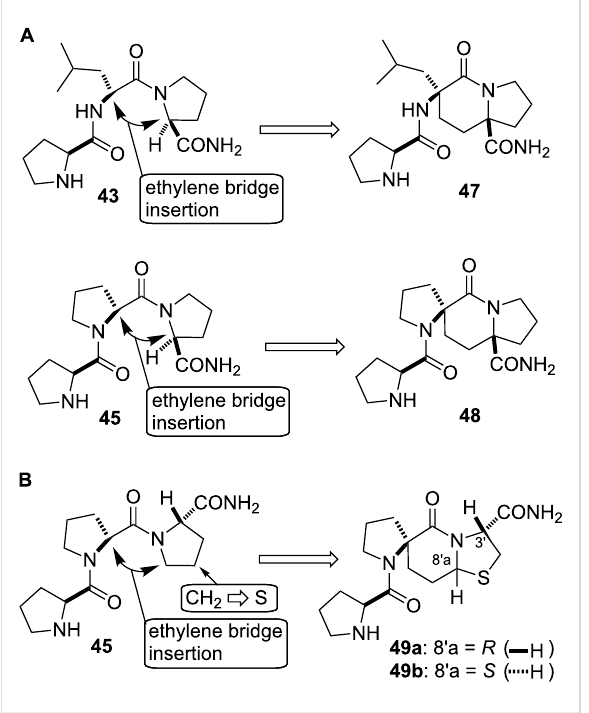
Figure 7. In one case, the presence of a prolyl residue intro- duces the possibility of a cis -amide bond at the C-terminus with the result being a type VI β -turn conformation. To test this hypothesis, Germanas’ indolizidinone scaffold [54] was employed as the type VI β -turn conformation mimic to design 47 and 48 (Figure 7A) [49,55]. A second possibility was that triproline 45 could assume a polyproline II helix conformation, wherein all the Pro–Pro amide bonds are in a trans -configur- ation. For testing this hypothesis, the spiro-bicyclic peptidomi- metics 49a and 49b were designed to mimic the polyproline II helix conformation (Figure 7B) [48,56]. These two spiro- bicyclic peptidomimetics are C-3’ epimers of the spiro-bicyclic type II β -turn mimics 29a and 29b .